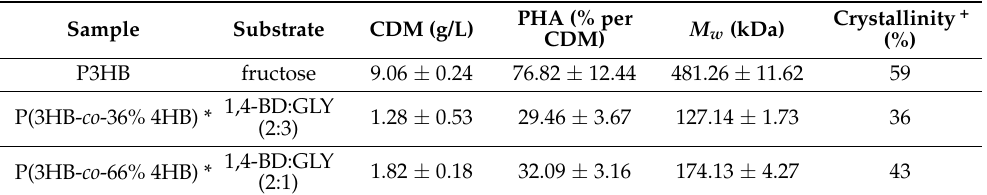
Table 1. Results of polymers production–also in [10].